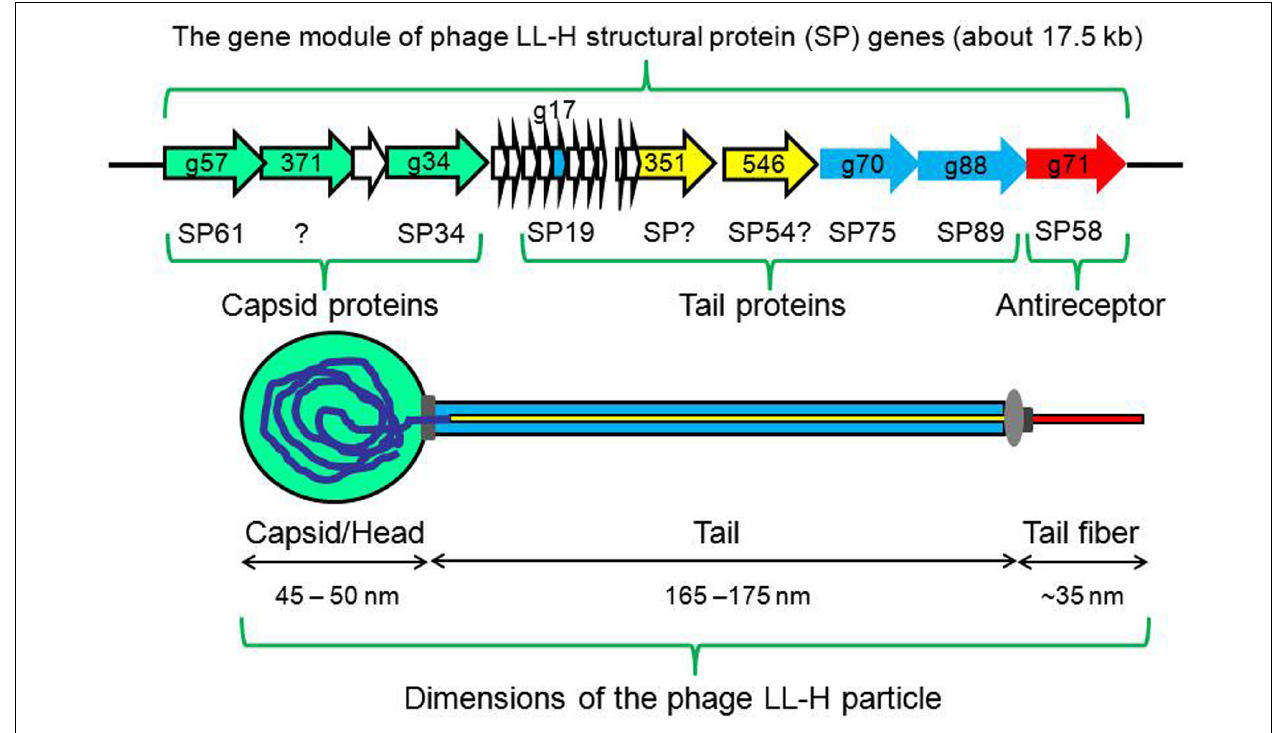
FIGURE 1 | Schematic diagram of phage LL-H particle. Genes encoding capsid and tail proteins are indicated as green and blue, respectively. Gene g71 (red) encodes the antireceptor protein SP58.The proteins coded by genes orf351 and orf546 (yellow) are considered as tape measure protein (TMP) homologs, likely localized to the core of the tail.The base plate is indicated as